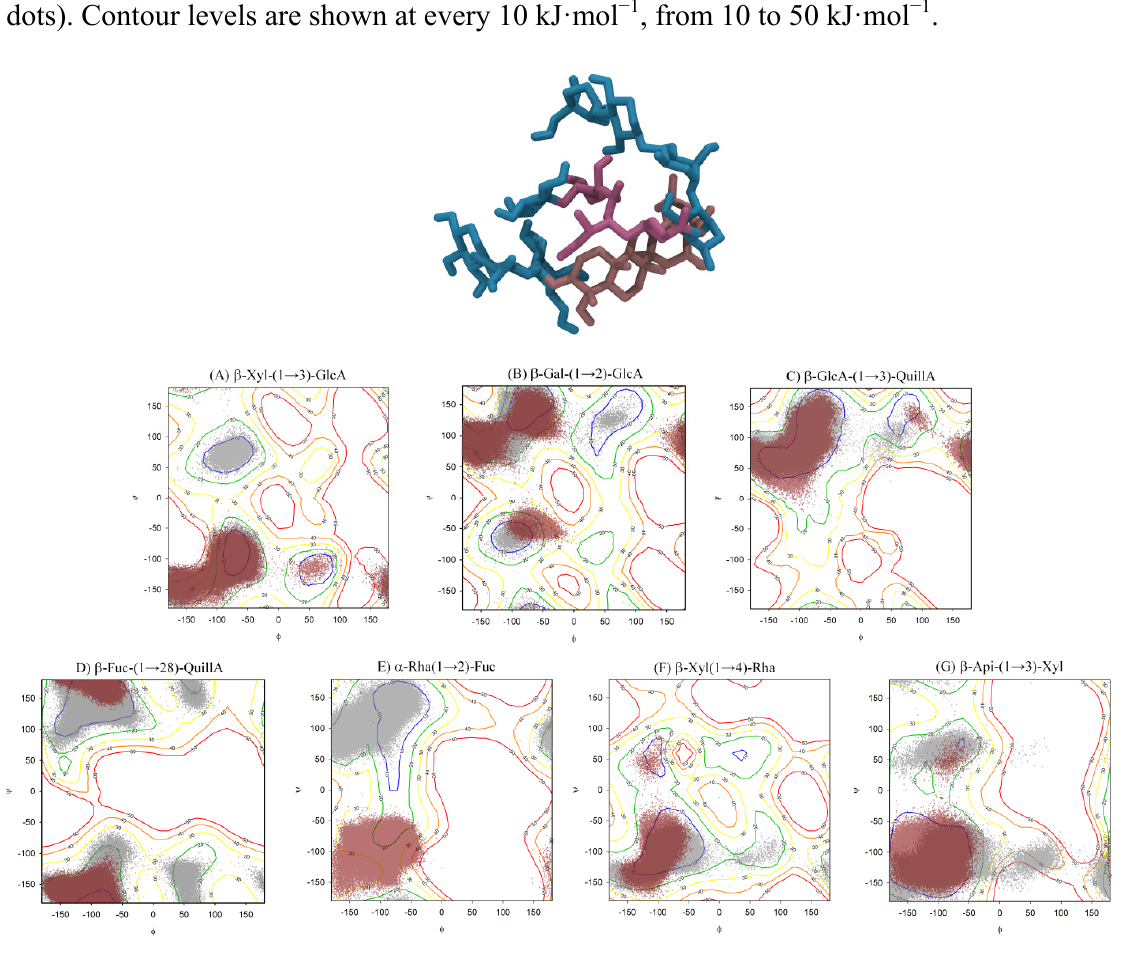
Figure 4. ( Top ) Representation of the whole molecule of QS-21 in its most prevalent conformation: the brown and purple parts represent the hydrophobic region and the blue part its hydrophilic portion. ( Bottom ) Energy contour plots for the glycosidic linkages that compose the QS-21 saponin. The corresponding aqueous solution populated geometries are superimposed as isolated units (gray dots) or as the complete saponin structure (dark red dots). Contour levels are shown at every 10 kJ·mol − 1 , from 10 to 50 kJ·mol − 1